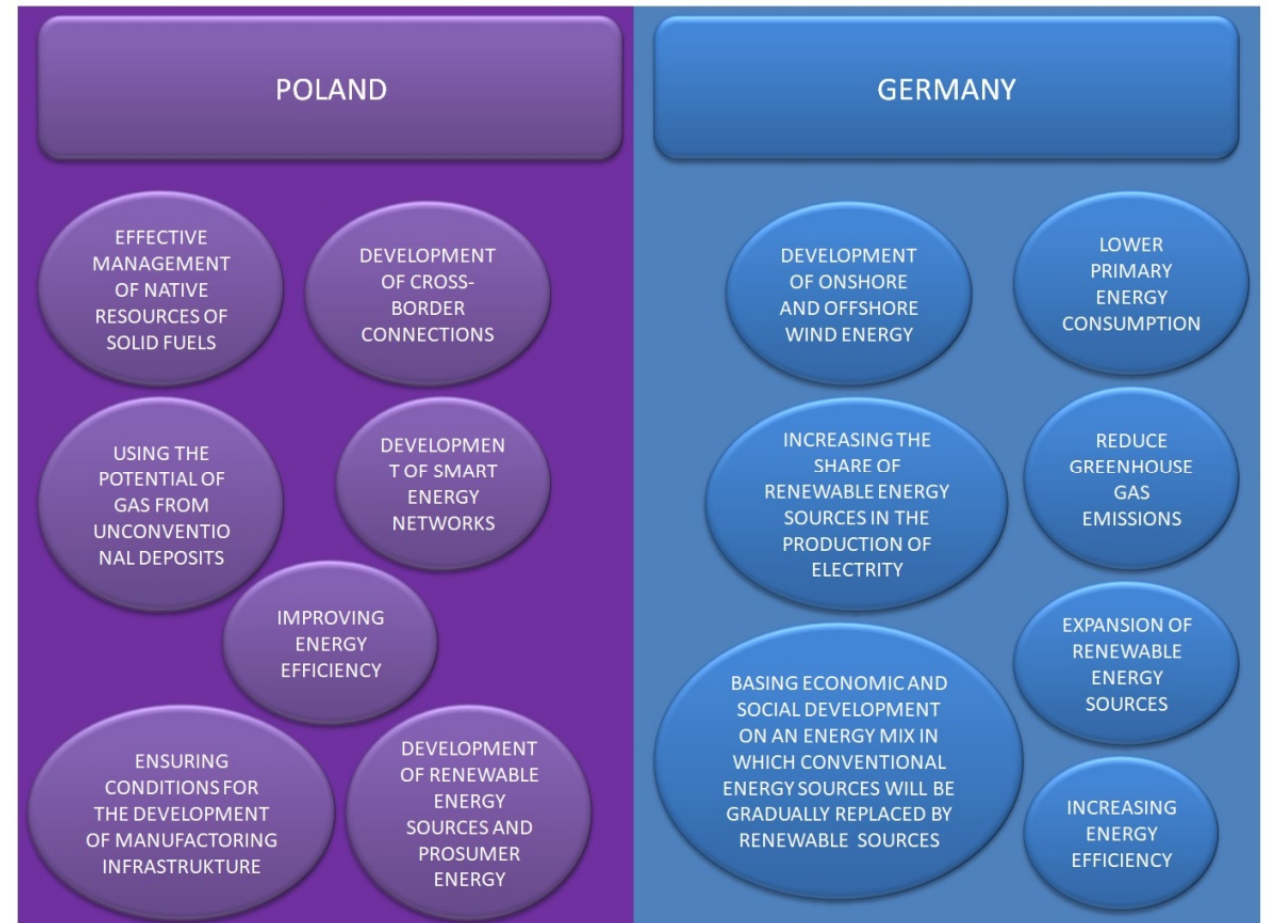
Figure 3. Actions to reduce the impact of energy on the environment [28].